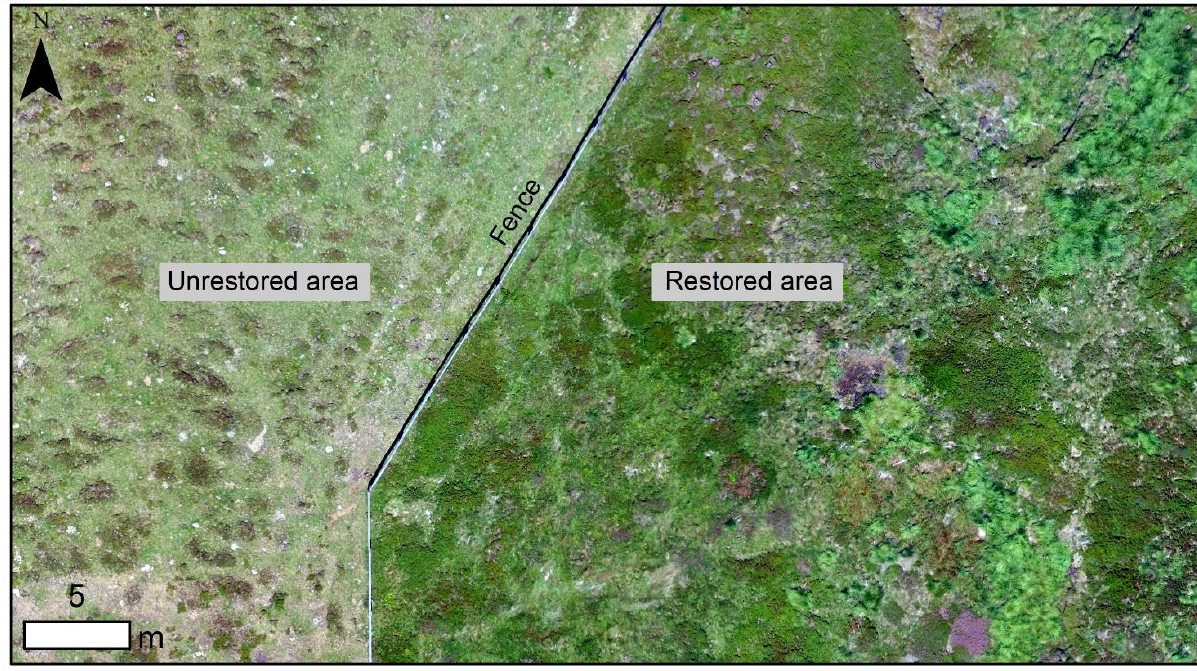
Figure 8. Visual difference in density and diversity of vegetation between restored and unrestored areas at Zalama (imagery captured using SenseFly eBee in July 2017 and processed using Pix4Dmapper).